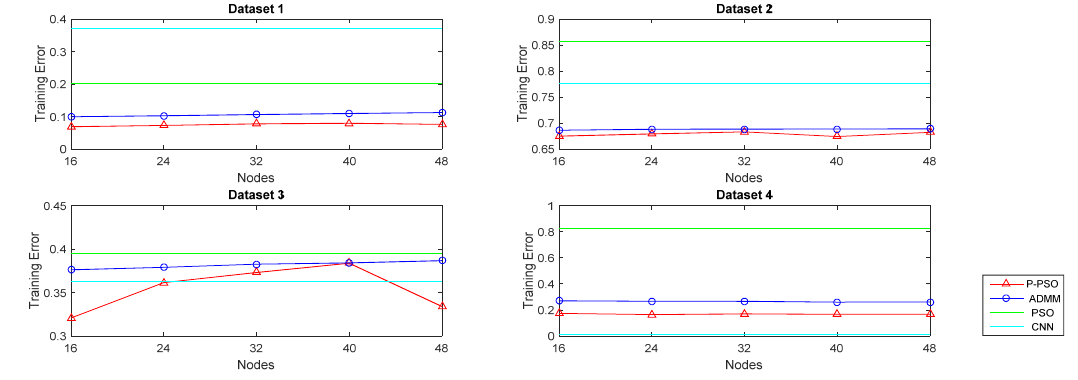
Figure 10. Training error comparison between traditional PSO, ADMM, CNN and P ‐ PSO~based distributed ESN algorithms. A typical length of data size (1 × 10 5 ) is selected for the four datasets.